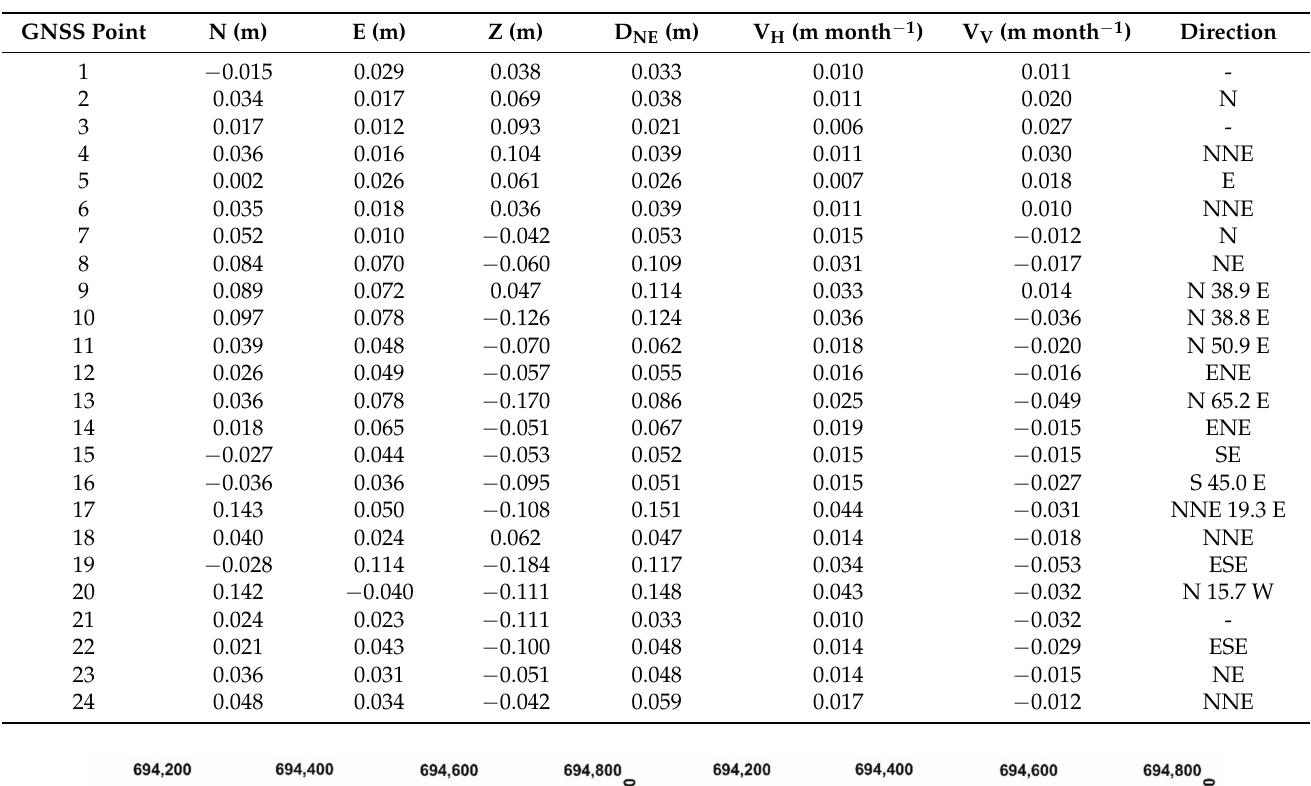
Table 5. Summary of effective N, E, and Z-axis displacements of GNSS points in Colinas Lojanas, showing the direction and velocity of each horizontal and vertical point.